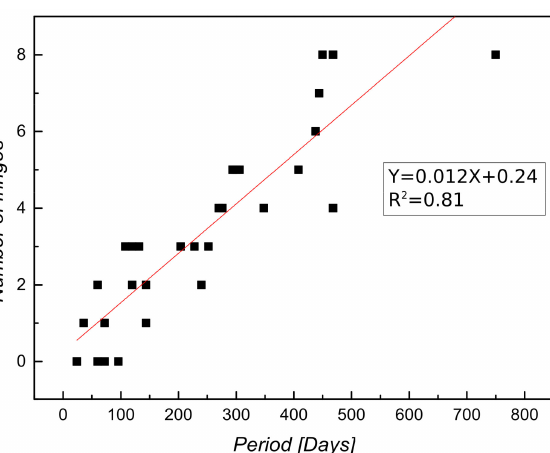
Figure 2. Di ff erential interferometric synthetic aperture radar (d-InSAR) maps allow relating the number of fringes ( y axis) versus the temporal baseline ( x axis). From the 27 data pairs, we deduced a linear trend of ~12 cm / year for the DVC